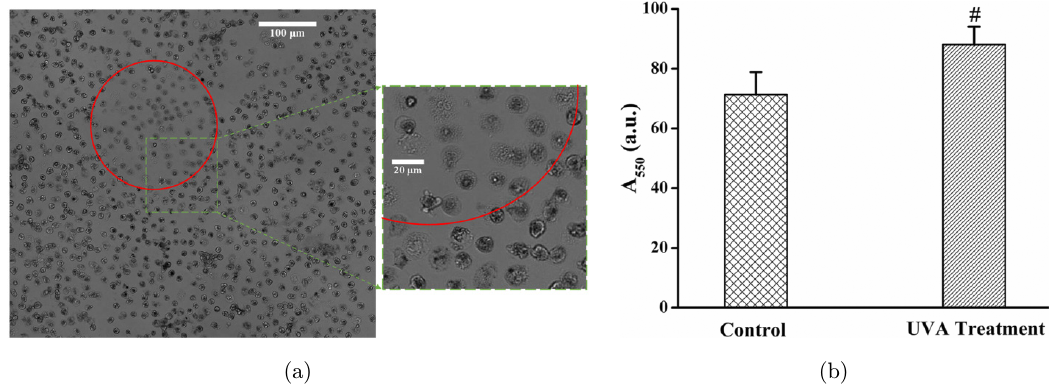
Fig. 4. UVA irradiation suppressed FMLP-induced phagocytosis in neutrophils. (a) Bright-¯eld images of neutral red uptake assay. The cells inside the red circle were treated by UVA. All neutrophils were stimulated by 2 (cid:1) M FMLP with neutral red for 30 min. (b) The relative phagocytic activity in each cell was represented by a gray value of A 550 . Statistical data are presented as the means (cid:4) SD ( n ¼ 45). p < 0 : 01, compared with